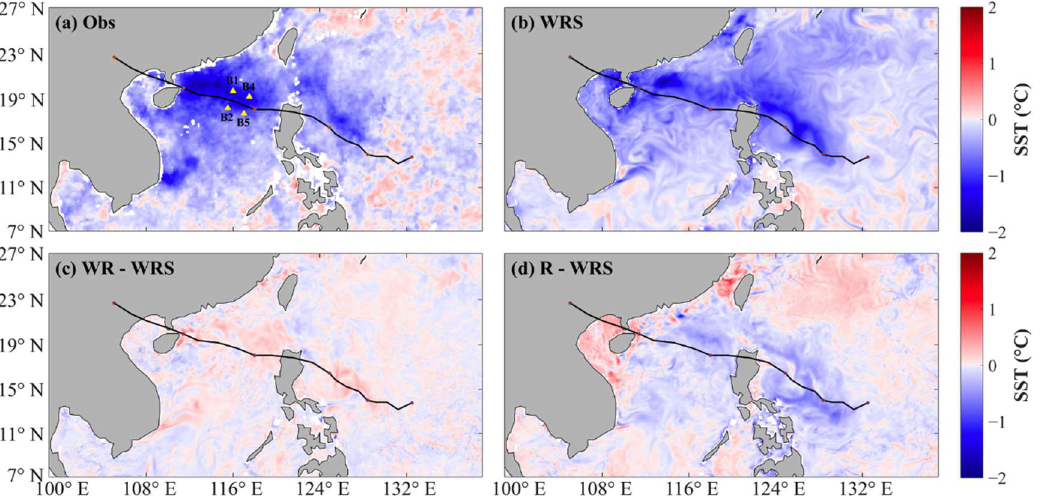
Figure 13. Spatial distribution of sea surface temperature differences (°C; background color). Difference between 16 September and 12 September for ( a ) satellite MW-IR observations; and ( b ) WRS coupled experiment. ( c ) WR minus WRS and ( d ) R minus WRS. The black line shows the TC track; the red dots are the TC positions between 12 to 17 September, with 1-day intervals, and the yellow triangles are the positions of the buoys.